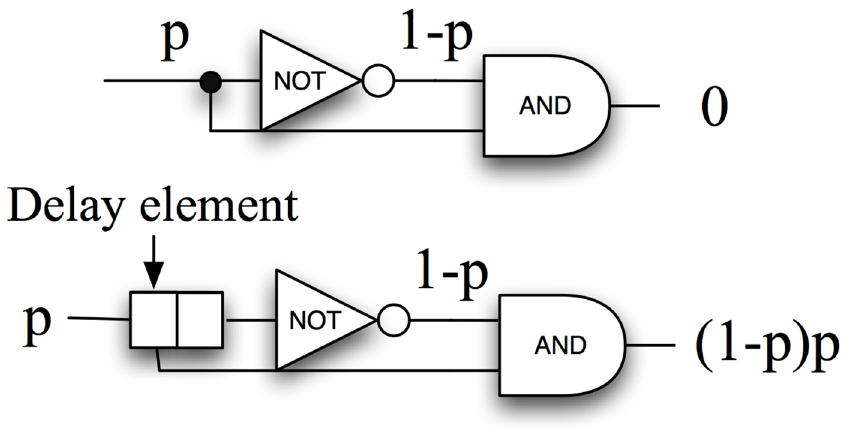
Fig 2. Correlation between signals and mathematical relationship between inputs and outputs. If we desire to implement the function p(1-p) we must add a delaying element to de-correlate signals at the input of the AND